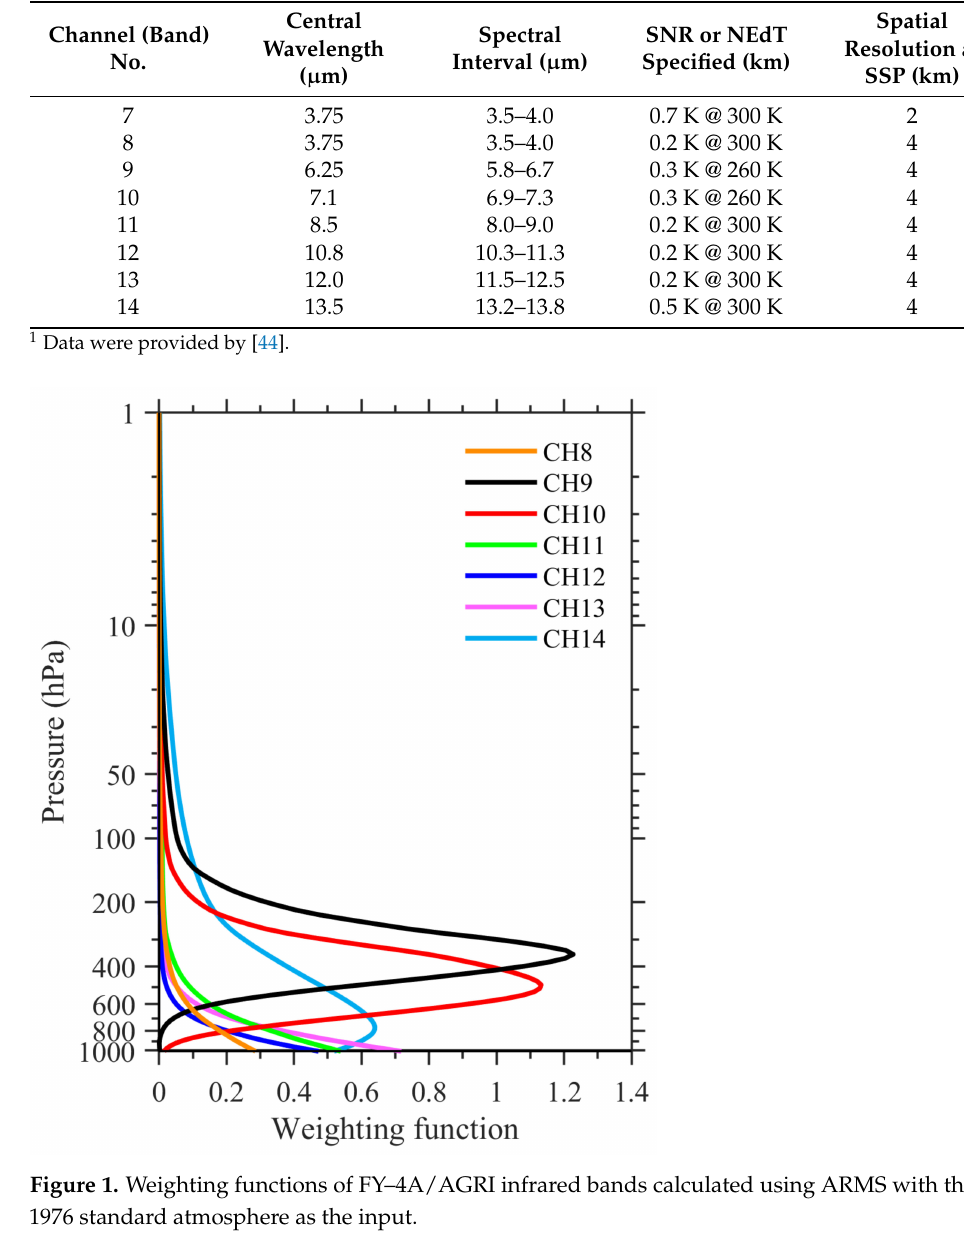
Table 1. Characteristics of FY–4A/AGRI infrared bands 1 .